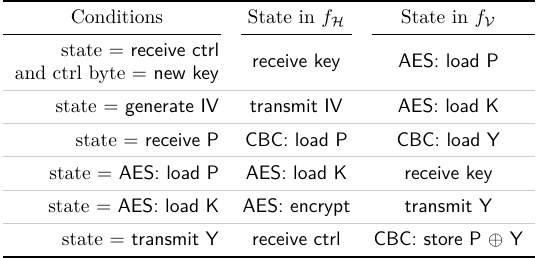
Table 3: Randomized changes to the state transitions of the central FSM